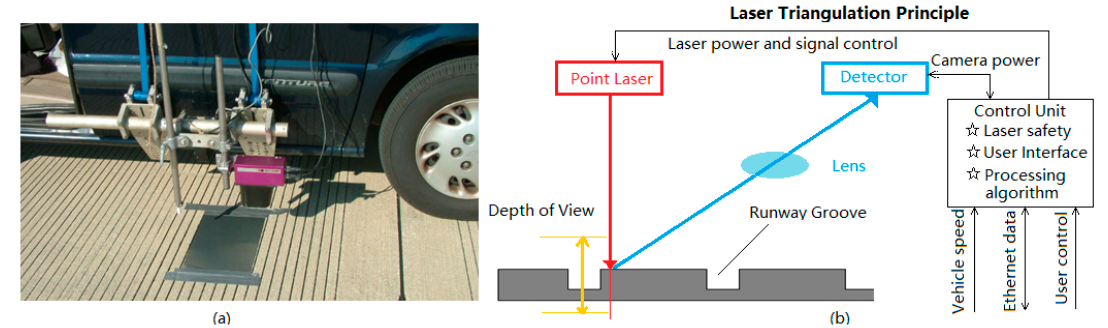
Figure 1. Photos of ( a ) FAA laser-based profiling system (Courtesy of photo in [12]); ( b ) Point laser profiling principle.